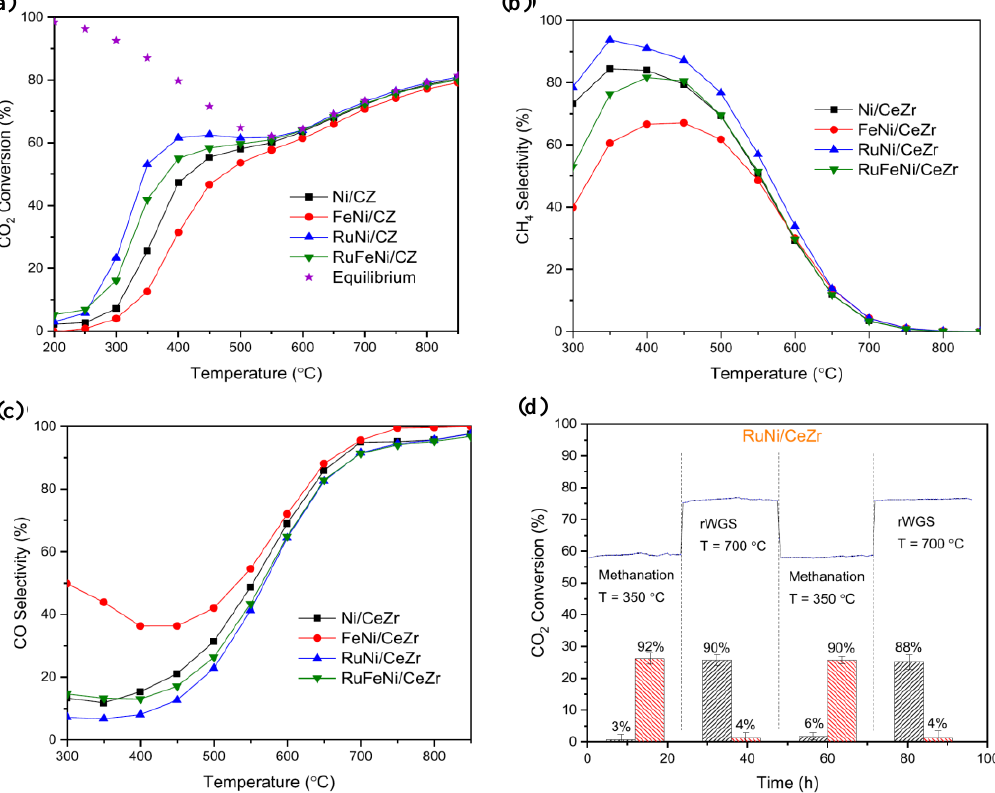
Figure 11. ( a ) CO 2 conversion, ( b ) CH 4 selectivity and ( c ) CO selectivity for all catalysts as a function of temperature. ( d ) Stability test for the RuNi/CeZr catalyst, varying the temperature between 350 and 700 °C and starting with the methanation cycle. Product selectivity is represented as columns, black for CO and red for CH 4 . Reproduced with permission from [70]. Copyright: American Society of Chemistry, Washington, DC, USA, 2020.